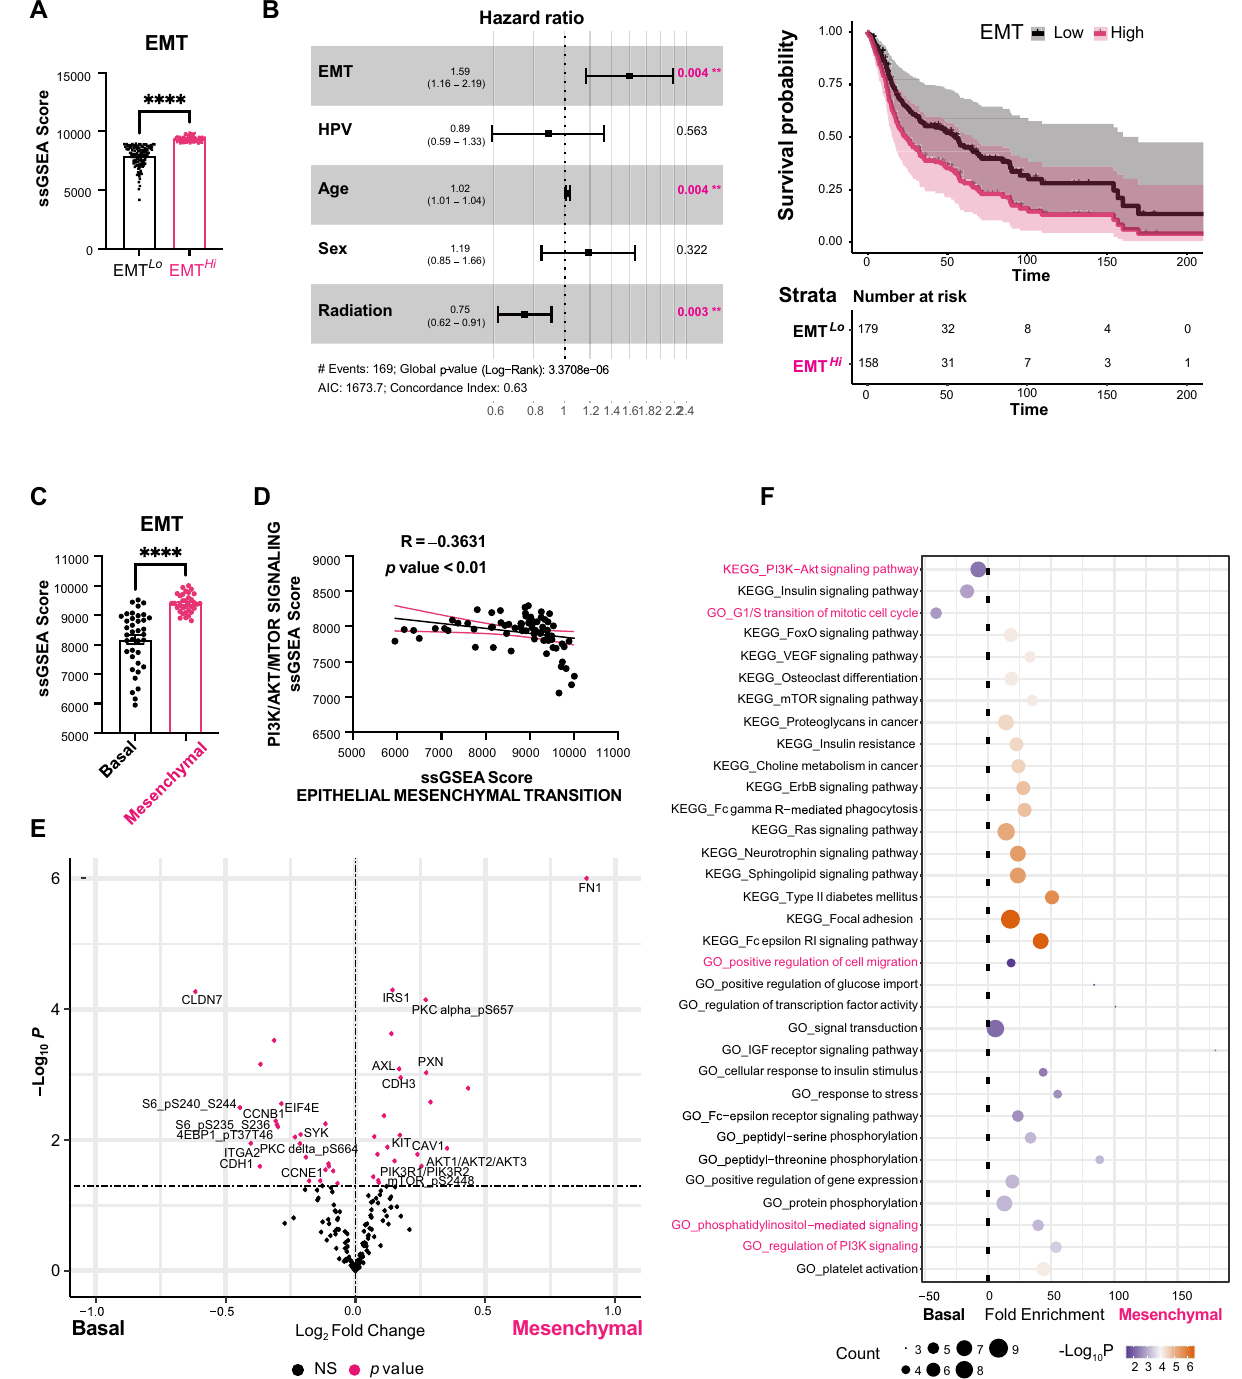
signature in malignant epithelial cells with a large stromal component and were described as malignant-basal 7 . Invasive cells at the leading edge of combined malignant-basal HNC undergo partial epithelial to mesenchymaltransition (p-EMT) 7 . While the classical and atypicalHNC subtypesareabletometastasiseatsimilarratestothemalignant-basal, they did not express p-EMT genes 7 . The p-EMT program reorganises the cell cytoskeleton to enable motogenesis at the expense of mito- genesis and manifests by decreased expression of epithelial markers (e.g. CDH1) and increased expression of mesenchymal markers (e.g. PDPN), required for HNC cell migratory and invasive abilities 8 – 10